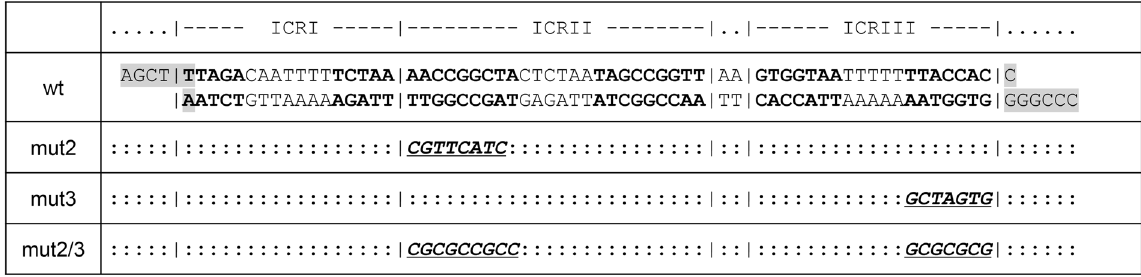
Table 2. Mutant oriD inverted complementary repeat (ICR) sequences.Mutant oriD oligoduplexes were synthesized and then ligated into the wild type (wt) pCer OriD plasmid to yield three oriD variants mut2, mut3 and mut2/3. The following symbols are used; “:” identical to wt; “|” delimits the three ICRs, bold indicates hairpin stems (see Fig. S3C); shaded regions are the restriction enzyme sites (HindIII and AvaI) used to resect the wild type pCer OriD plasmid so the synthesized oligoduplexes could be inserted and